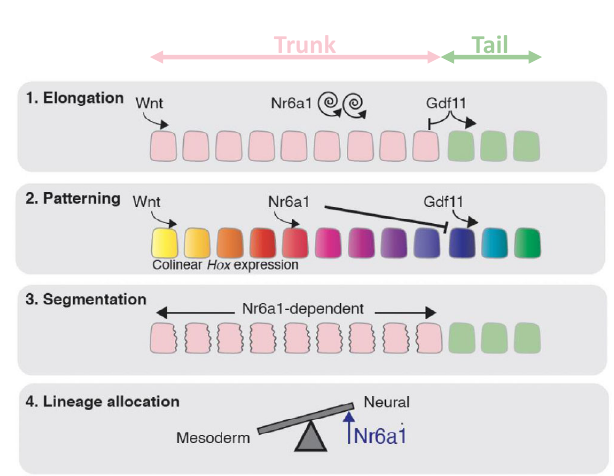
Fig.9 |Schematicsummary highlighting themultiplerolesofNr6a1within the tailbud. Blocks represent somites, pink = trunk-forming somites and green = tail- forming